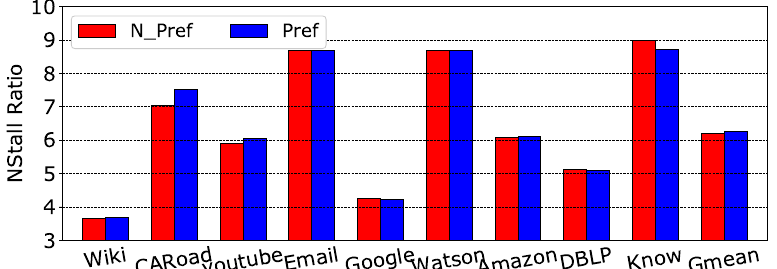
Figure 5. NStall ratio of graph traversal benchmarks without prefetch ( N_Pref ) and with stream prefetch ( Pref